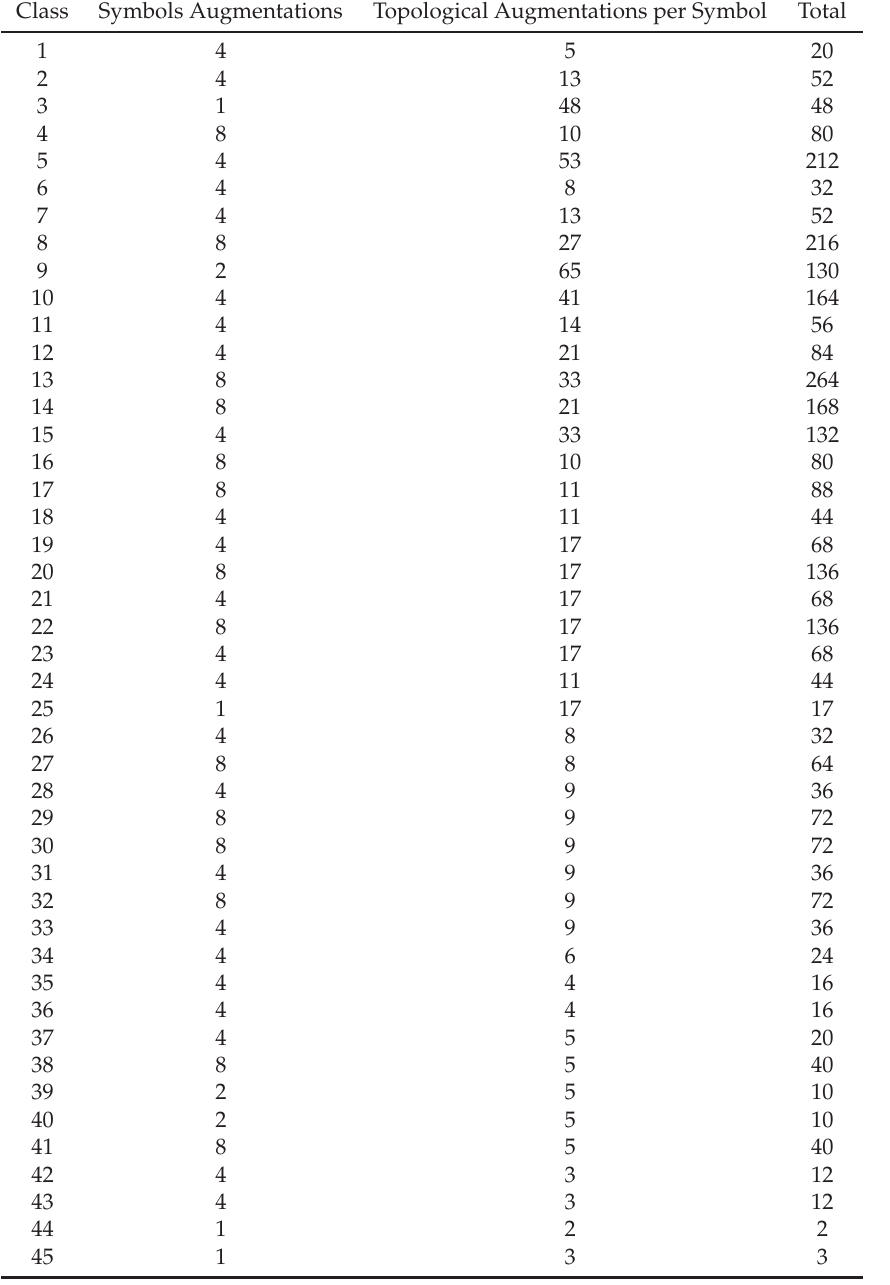
Table 2: Topological augmentation applied to the direction relation matrix (exemplar shown in Table